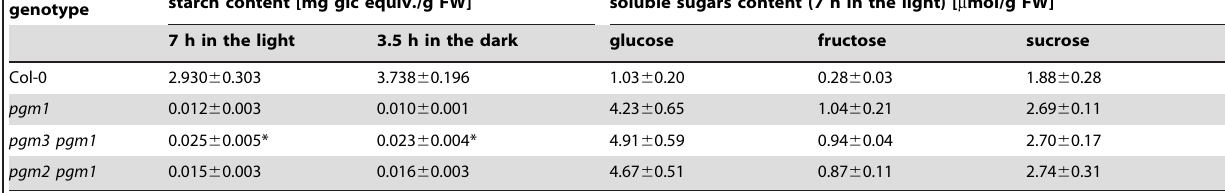
Table 3. Starch and soluble sugar content in Col-0 and PGM knock-out mutants.